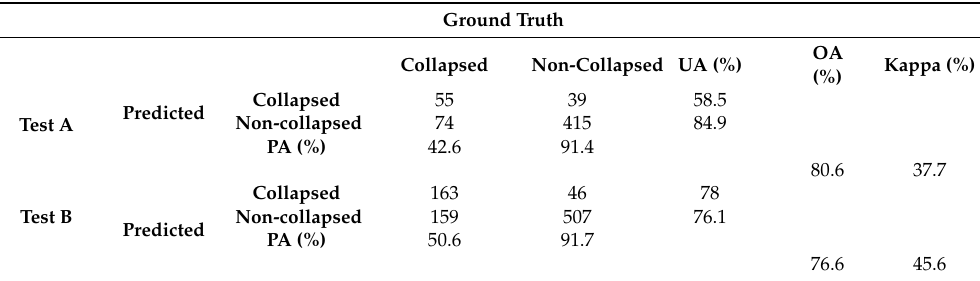
Table 3. SqueezeNet performance on test A and test B dataset.